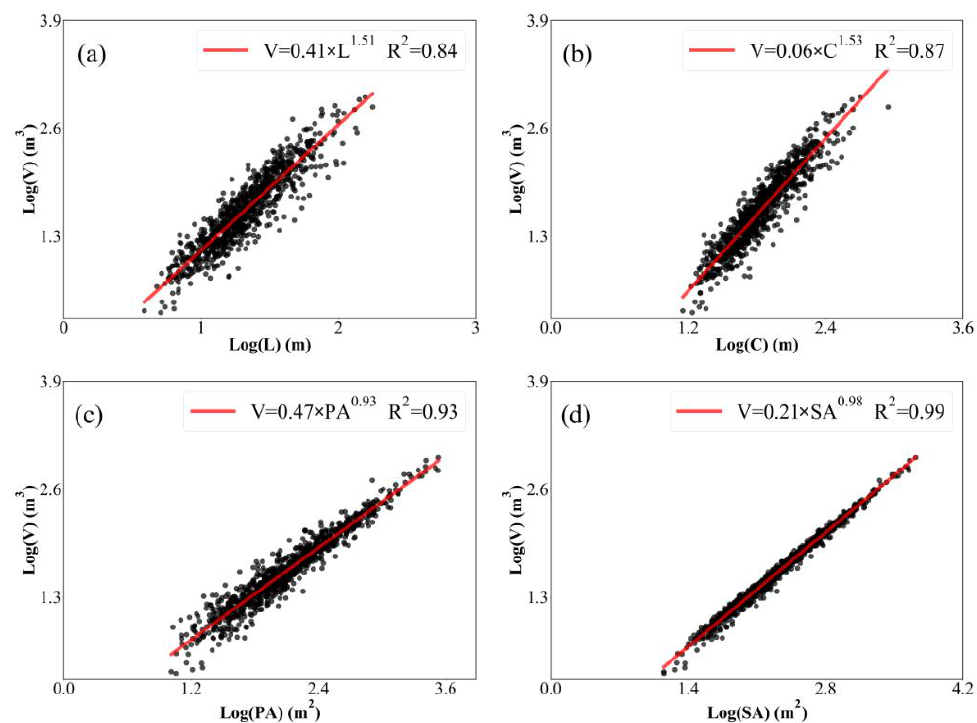
Figure 8. Power relations between gully volume (V), and ( a ) gully length (L), ( b ) gully circumference (C), ( c ) gully plane area (PA), and ( d ) gully surface area (SA).